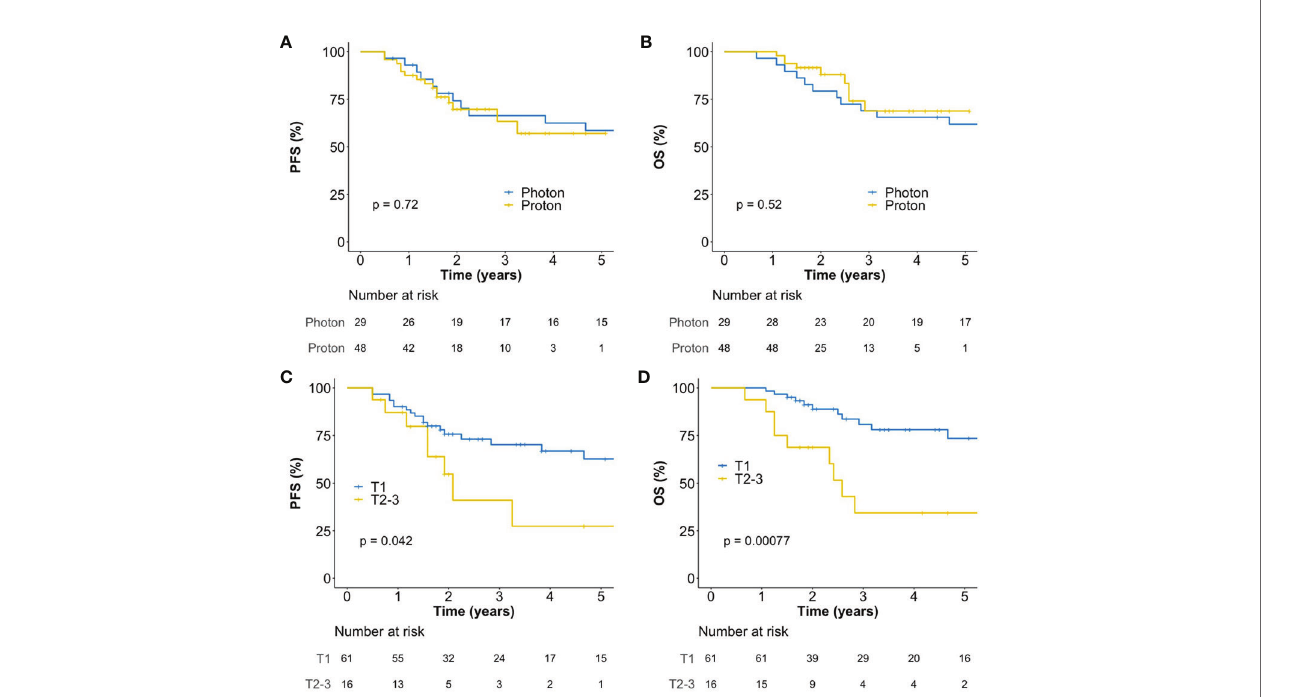
FIGURE 2 | Kaplan – Meier plot of progression-free survival (A) and overall survival (B) rates according to the use of photon RT and PBT in all patients over 60 months. Kaplan – Meier plot of progression-free survival (C) and overall survival (D) rates according to T stage over 60 months. OS, overall survival; PBT, proton beam therapy; PFS, progression-free survival; RT,